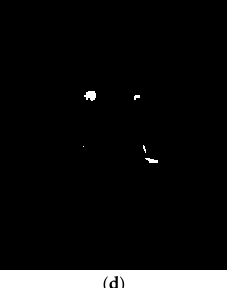
Figure 6. Lesion detection of Slice 97 with 1% noise and 0% INU by CBEP-ICEM1 and CBEP-ICEM2. ( a ) Original 97th slice of MS MR brain images with 1% noise and 0% INU; ( b ) CBEP-ICEM1; ( c ) CBEP-ICEM2; ( d ) Lesion detection LST.